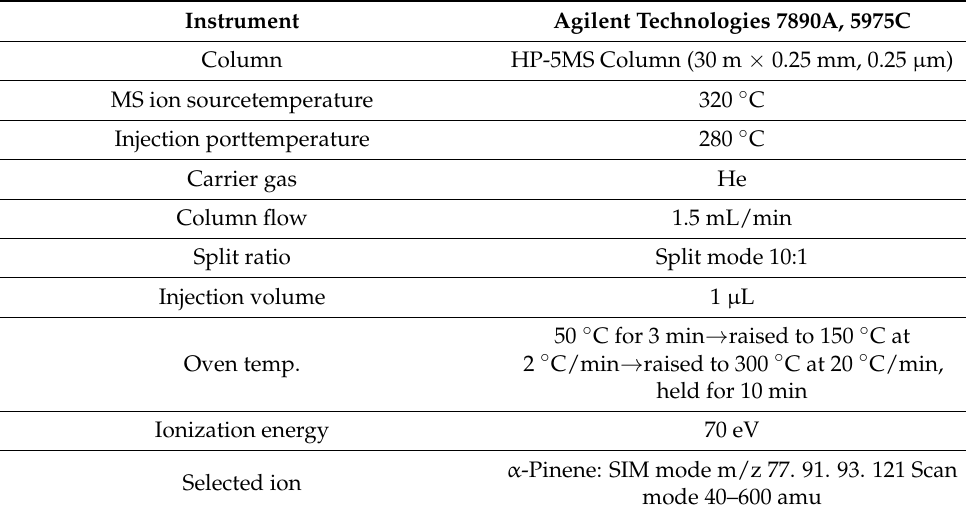
Table 1. Conditions of GC-MS analysis for phytoncide obtained by steam